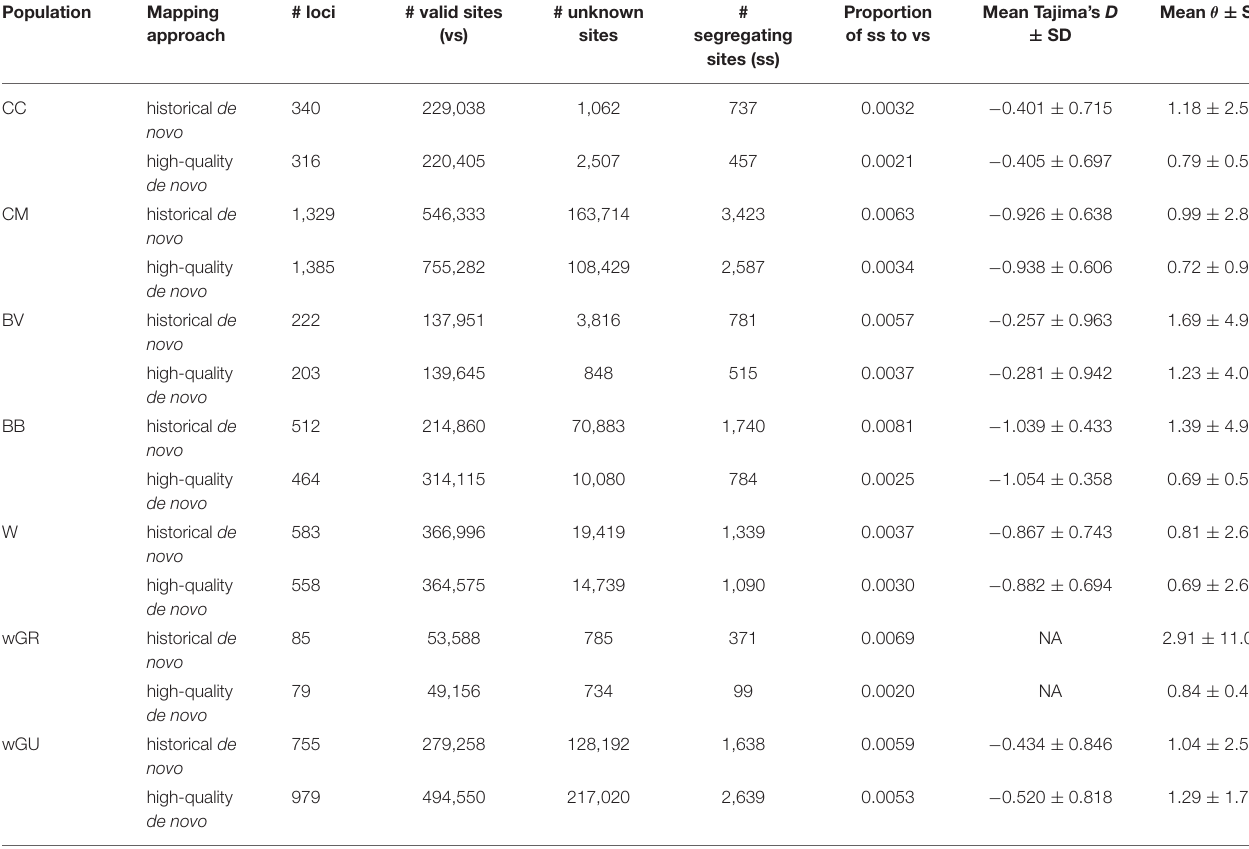
TABLE 3 | Population genomic summary statistics across rock-wallaby populations for both “historical de novo ” and “high-quality de novo ” mapping approaches.